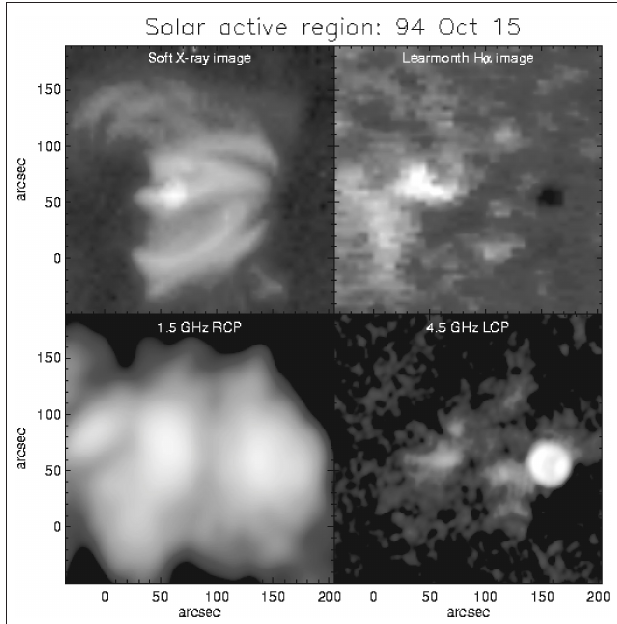
FIGURE 11 | Images of an active region. Top left : soft X-ray image obtained by Yohkoh Soft X-ray Telescope (SXT). Top right : H α image from Learmonth Observatory. Bottom left : 1.5 GHz VLA image in right circular polarization. Bottom right : 4.5 GHz VLA image in left circular polarization (image credit: S.M.